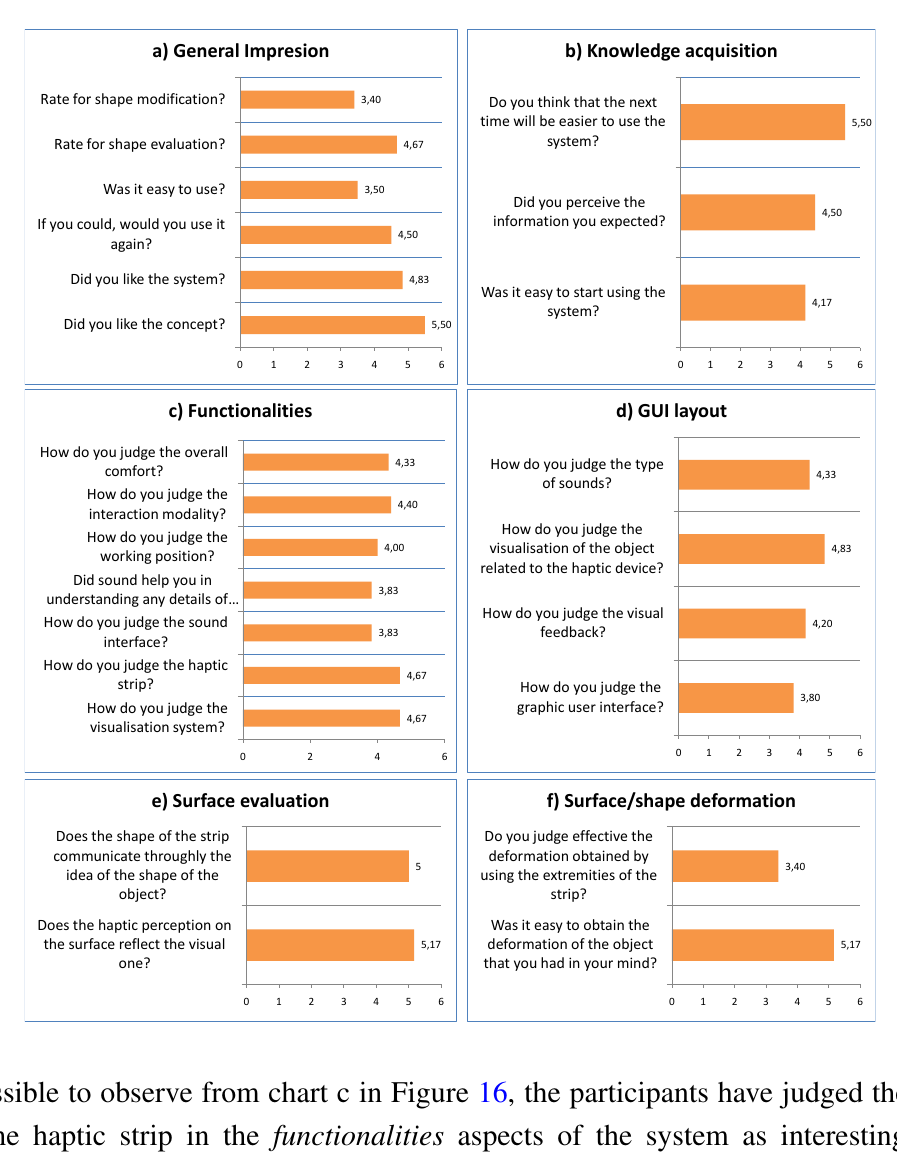
Figure 16. Show case